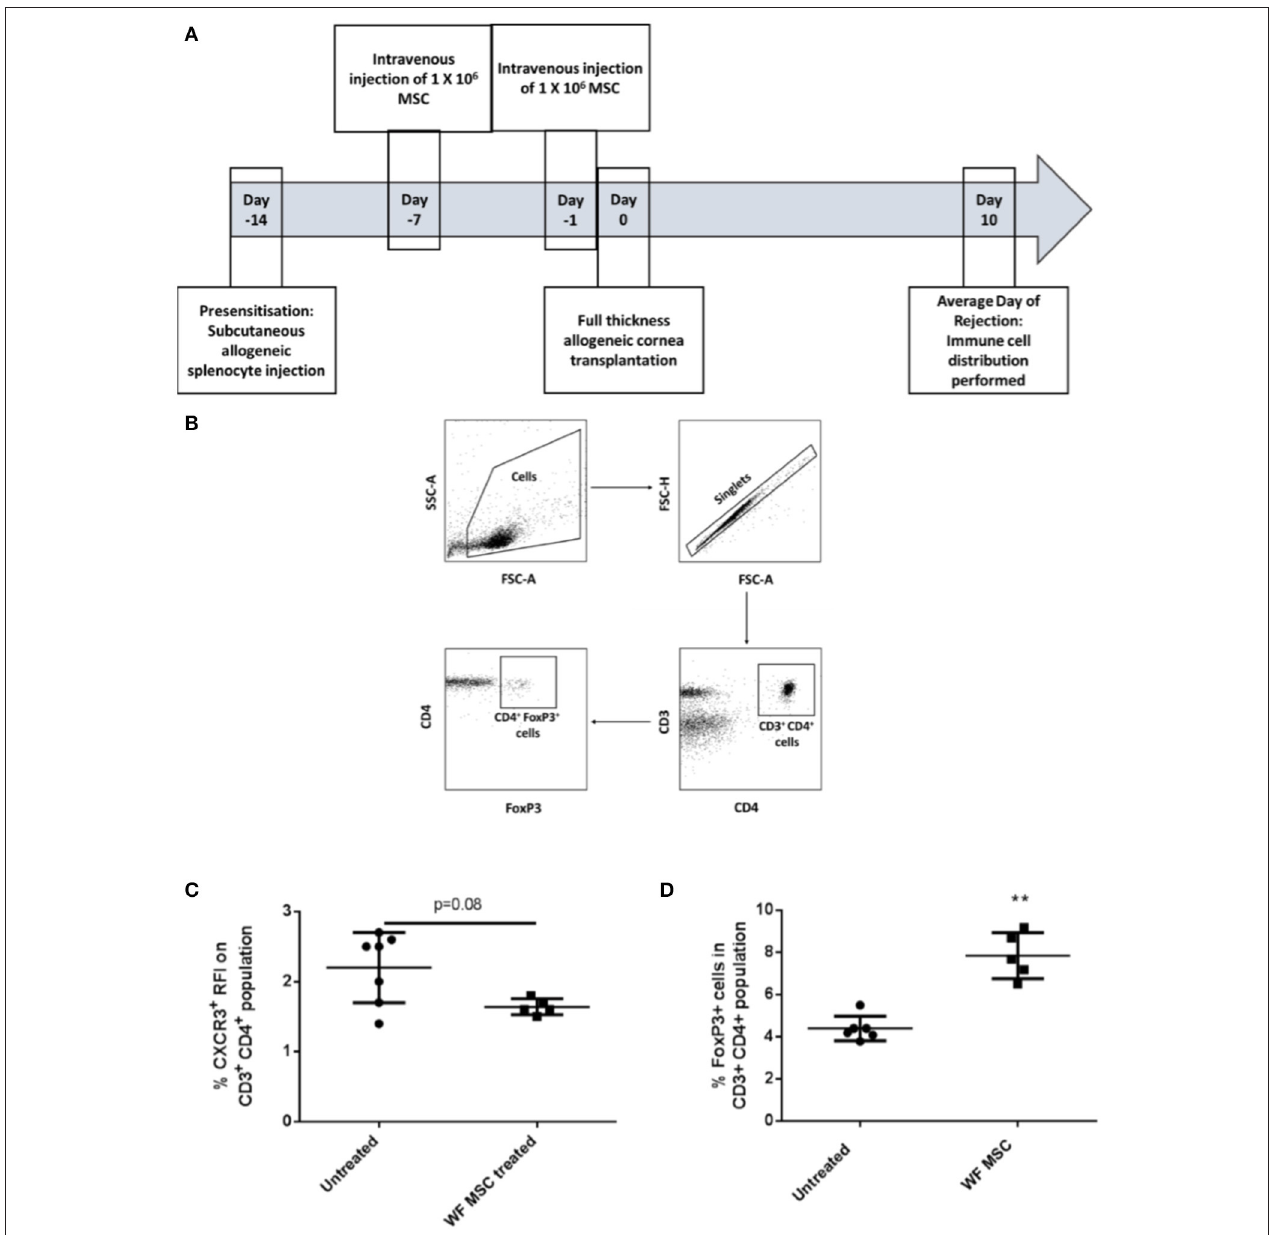
FIGURE 4 | Third-party allo-MSC administration to pre-sensitized Lewis rat corneal transplant recipients results in a proportionate increase in draining lymph node FoxP3 + (regulatory) CD4 + T-cells cells 10 days after transplantation. (A) Schematic representation of experiment to evaluate immune cell profiles at day 10 post-transplant in pre-sensitized Lewis rat recipients of DA corneal allografts following treatment with third-party allo-MSC. (B) Gating strategy used to identify FoxP3 + cells by flow cytometry (C and D). Graphs showing results of flow cytometry analysis of the proportions of CD3 + CD4 + T-cells co-expressing CXCR3 (C) and FoxP3 (D) in the graft-draining lymph nodes of pre-sensitized/untreated rats (Pre-sens, n = 6) and pre-sensitized/third-party allo-MSC treated rats (WF MSC treated, n = 5). Results for individual animals (symbols) and mean ± SEM for each group (horizontal lines with error bars) are shown. Statistical analysis was performed using one-way ANOVA with Tukey’s post-test, ** p <